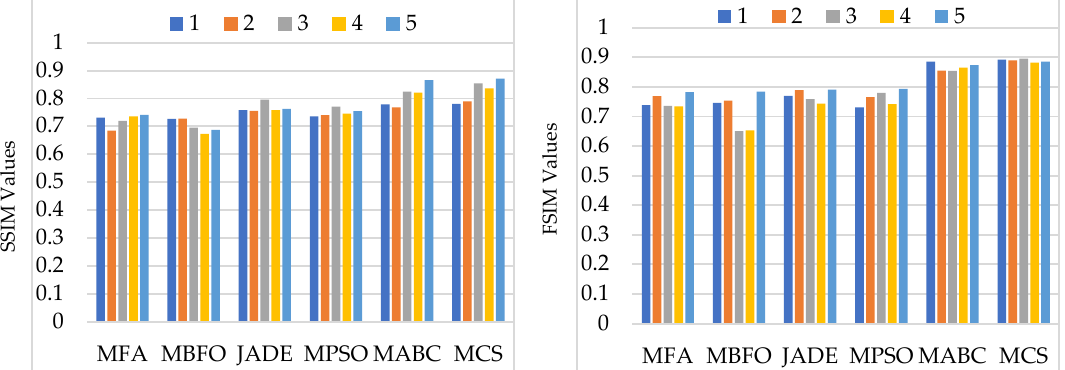
Figure 4. SSIM and FSIM using different optimization algorithms with EC-Otsu.